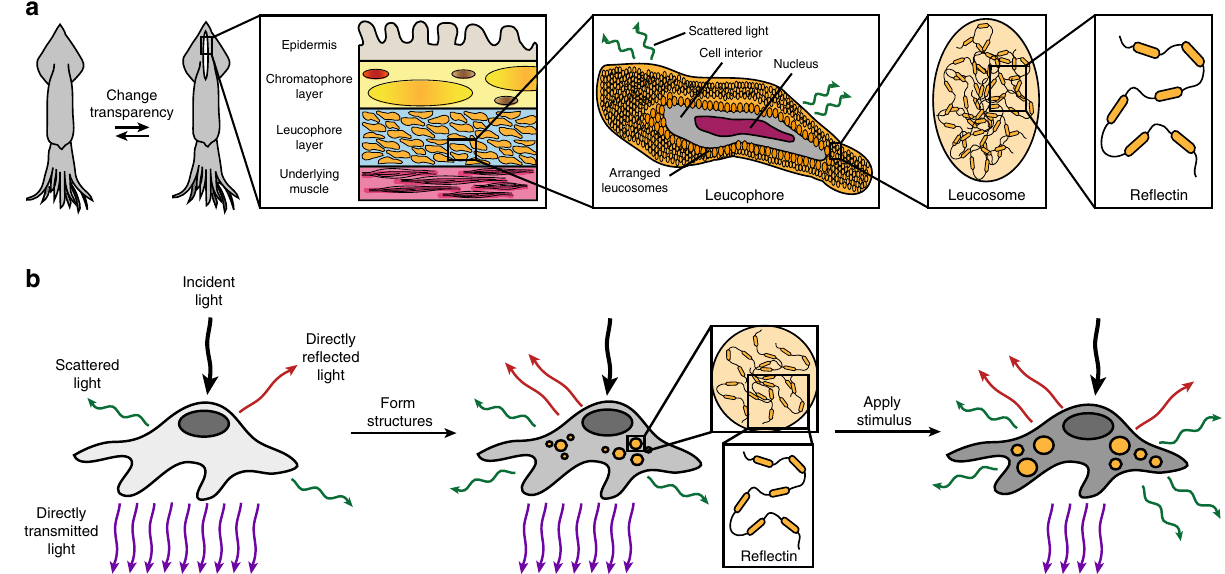
Fig. 1 Overview of the biological inspiration and the design of human cells with tunable optical properties. a An illustration of a female Doryteuthis opalescens squid that switches a white stripe on its mantle from nearly transparent (left) to opaque white (right). (Inset, left) An illustration of a cross- section of the white stripe that shows the epidermis, chromatophore layer, leucophore layer, and underlying muscle. (Inset, middle left) An illustration of a leucophore, wherein the membrane contains an embedded arrangement of proteinaceous structures called leucosomes. The arrangement enables the cell to diffusely re fl ect, i.e. scatter, visible light. (Inset, middle right) An illustration of a leucosome, which contains assembled re fl ectin proteins. (Inset, right) A generalized illustration of a re fl ectin isoform. b (Left) A schematic of a human cell before transfection, which contains organelles as its only subcellular structures. The cell directly transmits (purple arrows) most of the incident visible light (black arrow) with relatively minimal scattering (green arrows). (Middle) A schematic of a human cell after the expression of re fl ectin and the formation of photonic architectures, i.e. a disordered arrangement of high refractive index, re fl ectin-based structures (orange circles), within its interior. The cell diffusely transmits and/or diffusely re fl ects, i.e. scatters (green arrows), some of the incident visible light (black arrow). (Right) A schematic of a human cell after exposure to a chemical stimulus that in fl uences re fl ectin assembly, which demonstrates a plausible modi fi cation of the geometries and/or arrangements of its photonic architectures (orange circles). The cell now diffusely transmits and/or diffusely re fl ects, i.e. scatters (green arrows), a different amount of the incident visible light (black